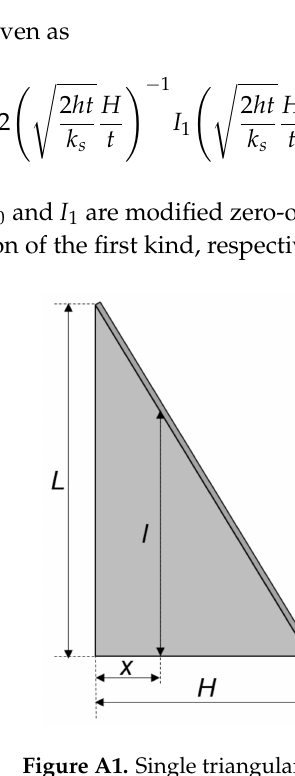
Figure A1. Single triangular